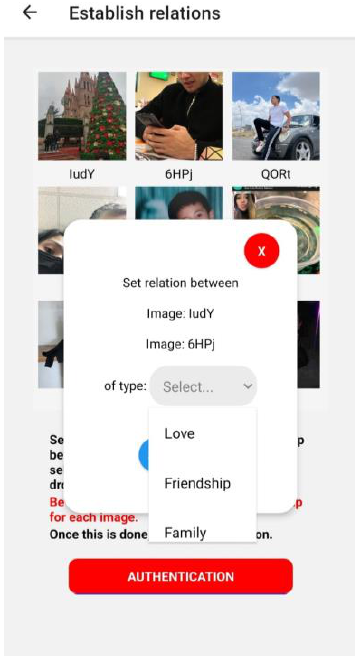
Figure 5. Establish-relations